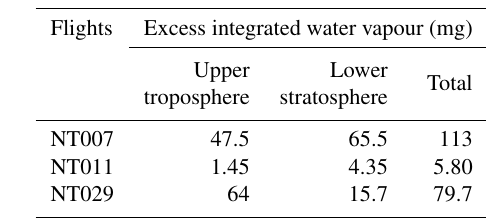
Table 3. Integrated water vapour in the stratosphere and upper troposphere for flights NT007, NT011 and